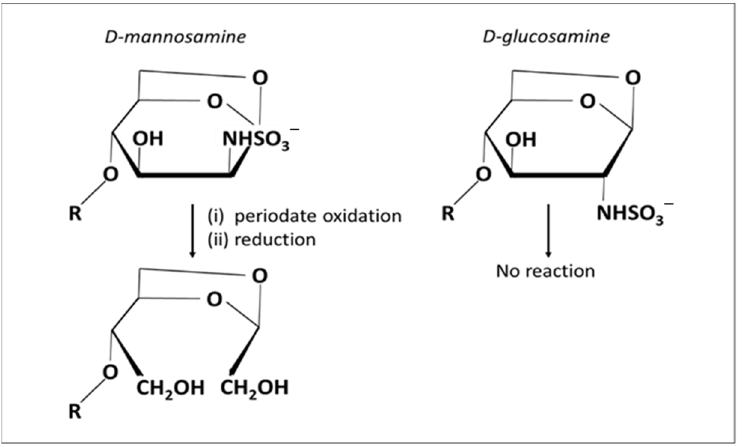
Figure 5. Terminal 1,6 - anhydro - D - mannosamine residues (upper left) formed during depolymerization under basic conditions, during enoxaparin manufacture, are oxidized by periodate to cleave the carbon to carbon (C2-C3) bond. The aldehydes formed can be reduced further to alcohols (lower right). Terminal 1,6 - anhydro - D - glucosamine residues (upper right) in enoxaparin are not susceptible to periodate oxidation.